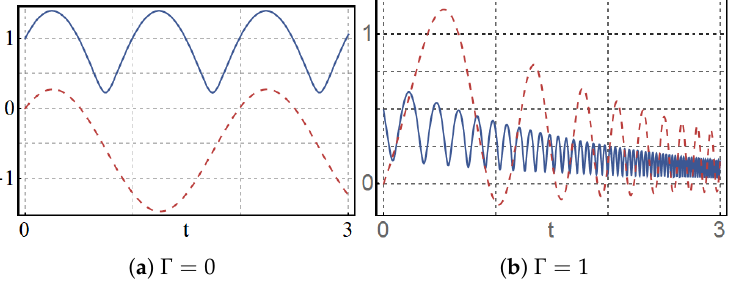
Figure 3. Solution to the Ermakov equation σ ( t ) (blue-solid) and the non-homogeneous equation γ ( t ) (red-dashed) for the mass term e − Γ t /2 for the constant mass case Γ = 0 ( a ) and Γ = 1 ( b ). Moreover, in ( a ), we have used A and ϕ as in Figure 1, whereas in ( b ), we have used (cid:96) 1 and (cid:96) 2 as in Figure 2. The remaining parameters have been selected in both cases as a = c = w 0 = 1, Ω = 1.5, v 0 =